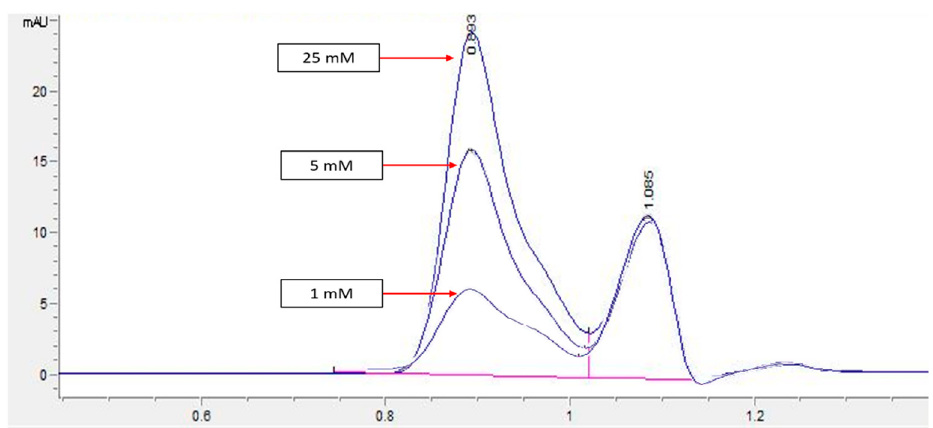
Figure 3. HPLC chromatogram profile for mimosine. Peak heights increased as the concentration of mimosine increased specifically at RT 0.9 min from 7.45 for 1 mM to 24.37 mAU for 25 mM. Key: y -axis: mAU, milli-absorbance unit; x -axis: min, minutes.